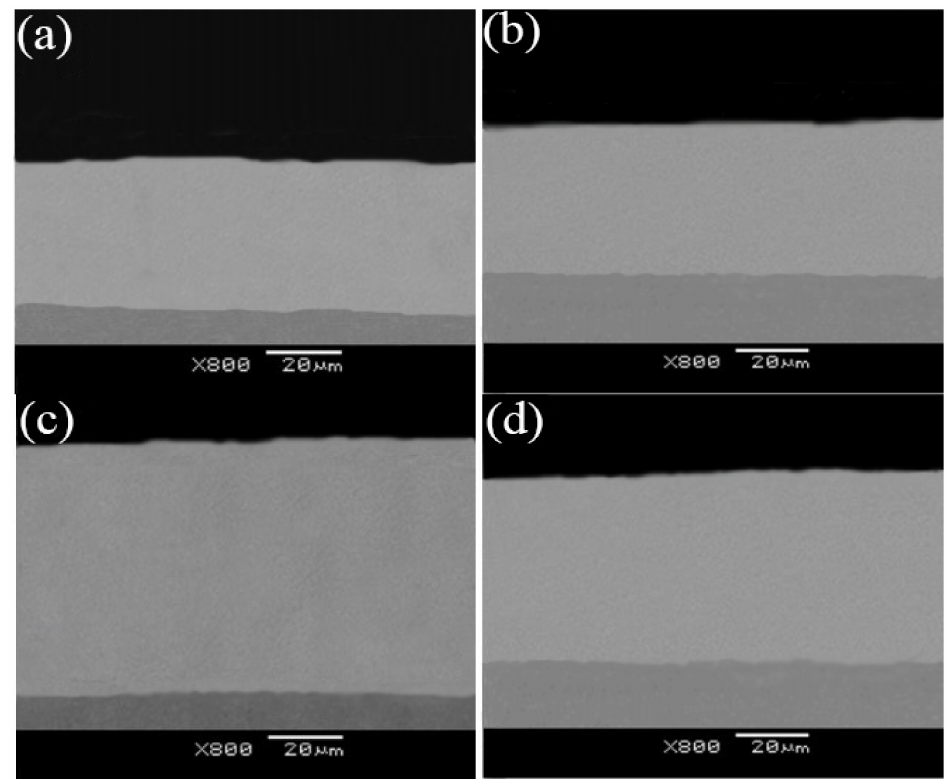
Figure 6. The fractography of Ni–TiN coatings deposited at different nozzle diameters: ( a ) Nf = Φ 3 mm, ( b ) Nf = Φ 5 mm, ( c ) Nf = Φ 7 mm, ( d ) Nf = Φ 9